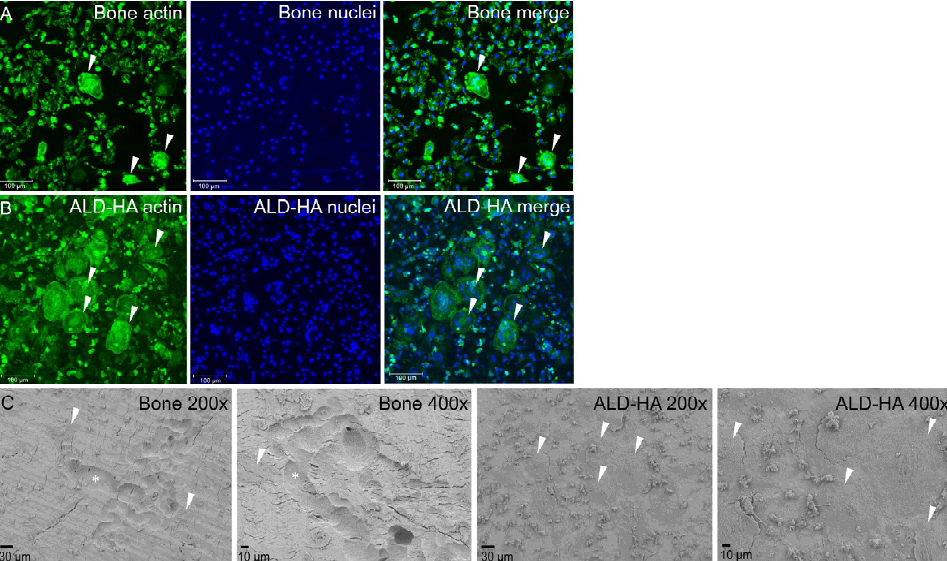
Figure 3. Confocal microscope ( A , B ) and FESEM ( C ) images of multinuclear cells and resorption on bone and ALD-HA. When stimulated with osteoclastogenic growth factors RANKL and M-CSF, peripheral blood monocytes differentiated into small multinuclear cells (arrowheads) with actin rings on bone ( A ), whereas on ALD-HA large multinuclear cells were generated ( B ). Bone resorption was evident on bone surface (( C ); asterisks), and occasional small osteoclasts (arrowheads) were observed in or near the resorption pits. ALD-HA was devoid of resorption pits but was covered with large, flat multinuclear cells (arrowheads).